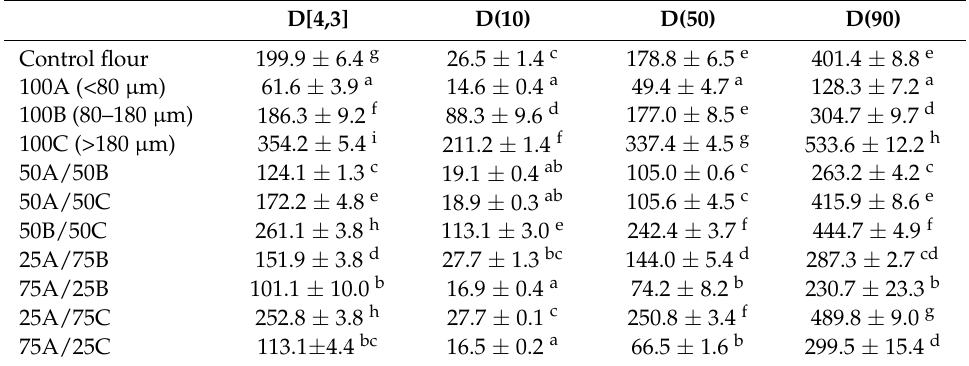
Table 2. Maize flour, maize flour fractions and their combinations particle size